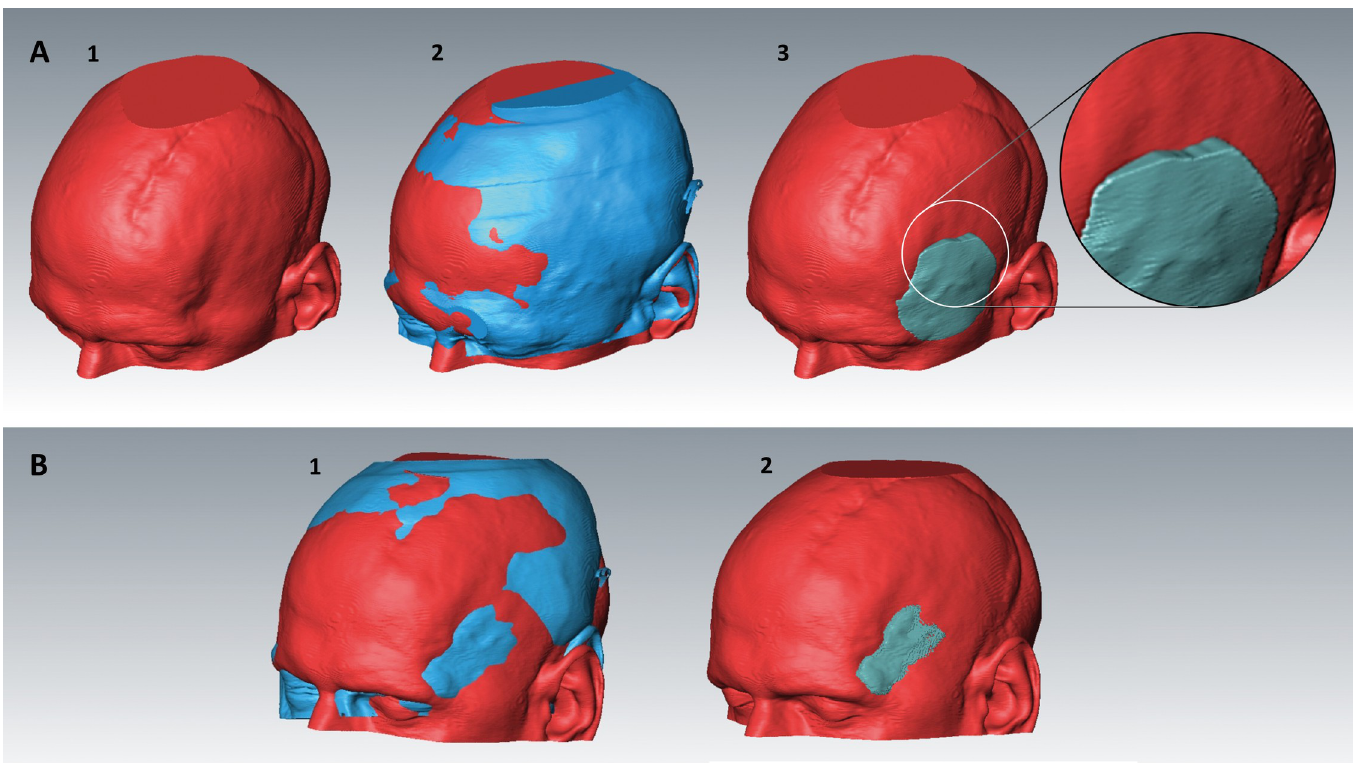
Fig 2. Illustration of manual skin surface matching in cases of insufficient automatic matching quality. A1 late-CT with hollowing defect of the left temple, A2 insufficient automatic matching due to soft tissue swelling in pre-CT (head trauma case, blue), A3 inaccurate, wedge formed defect volume . B1 manually corrected skin surface matching to obtain the narrowest and best isolated defect volume at the aesthetically relevant area B2 resulting correct defect volume.